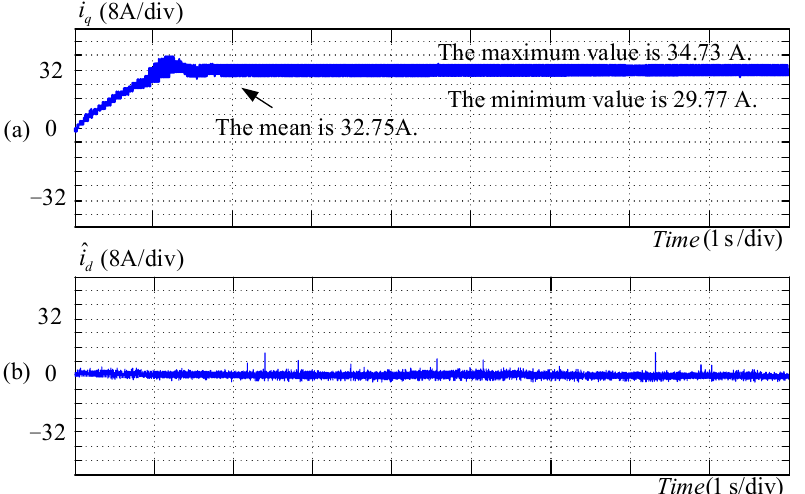
Figure 8. Measured q-axis and d-axis currents of a three-phase permanent-magnet synchronous motor driven at 1500 rpm without compensation for harmonic components in induced EMF: ( a ) measured ˆ i r q ; ( b ) measured d